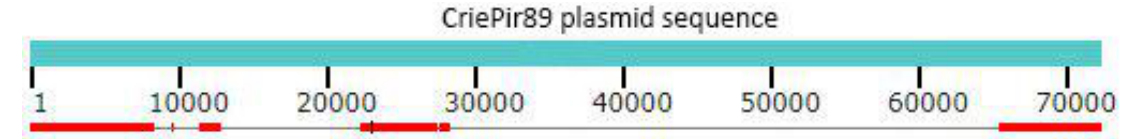
Figure 2. Graphic illustration of CriePir89 plasmid parts identical to the parts of CriePir75 plasmid. Identical parts are shown in red.